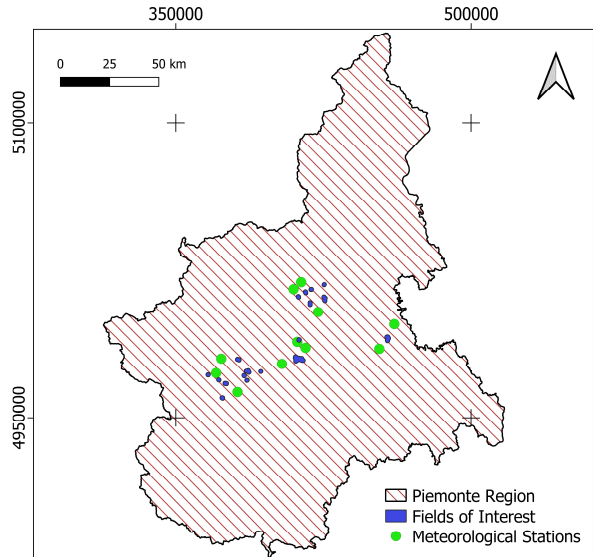
Figure 3 . Meteorological Stations taken into account for the study. (Reference System: WGS84/UTM 32